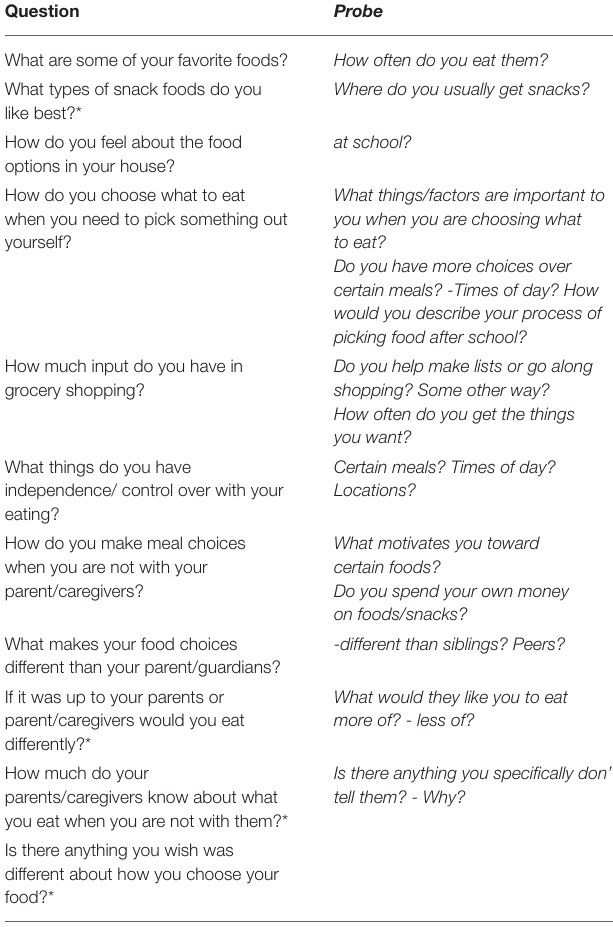
TABLE 1 | Focus group discussion guide questions and